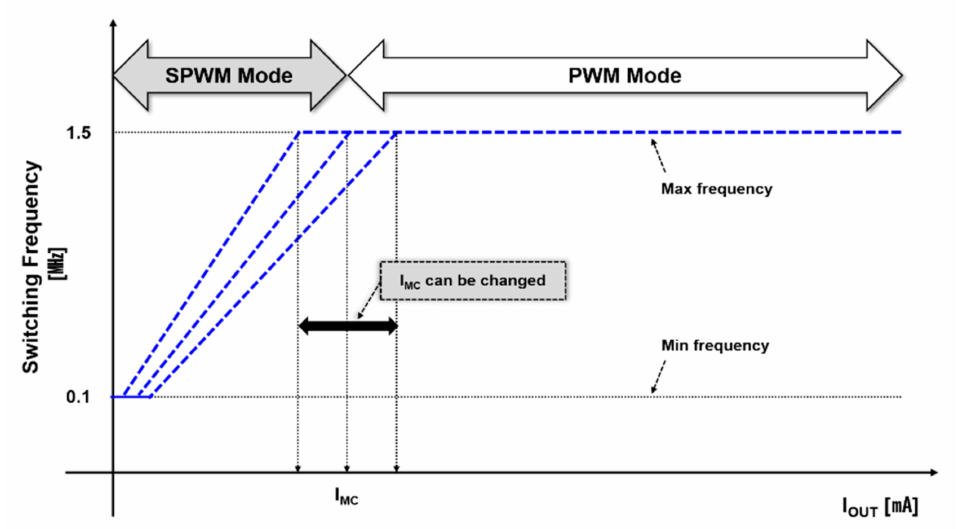
Figure 6. Switching frequency vs. output current of the PWM–SPWM dual mode switching